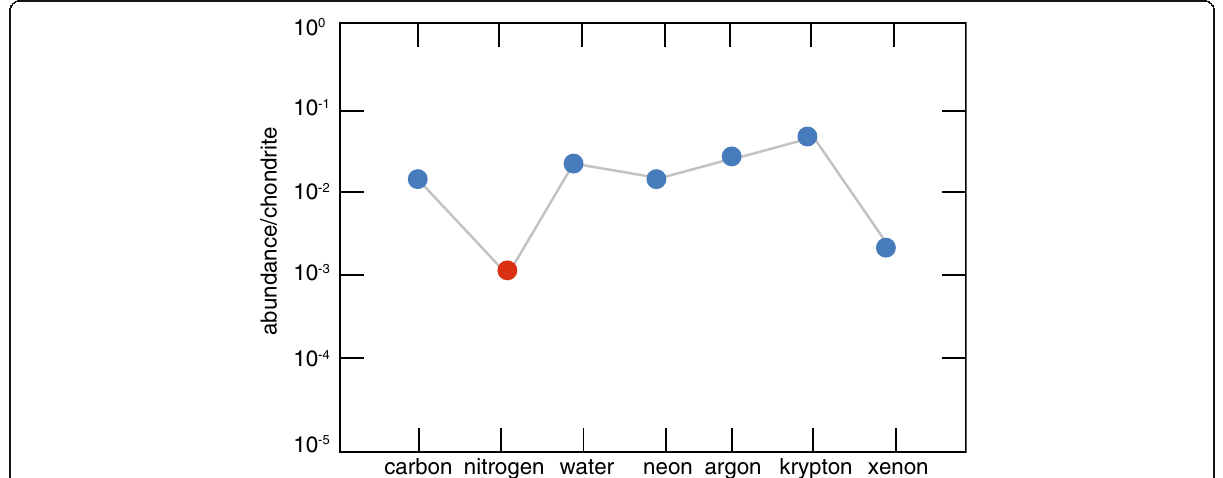
Fig. 10 Chondrite-normalized noble gas, carbon, and nitrogen content of the silicate earth (modified from Marty 2012)